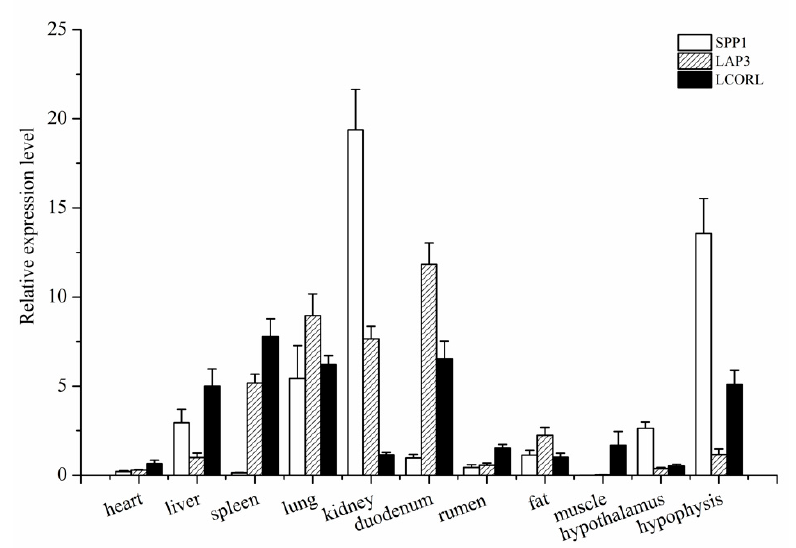
Figure 2. The mRNA expression profiles of SPP1 ( A ), LAP3 ( B ), and LCORL ( C ) in various tissues of sheep. The expressing of these three genes was by qPCR and normalized to the expression of GAPDH , each sample was amplified in triplicate and the data were shown as mean ± standard deviation.